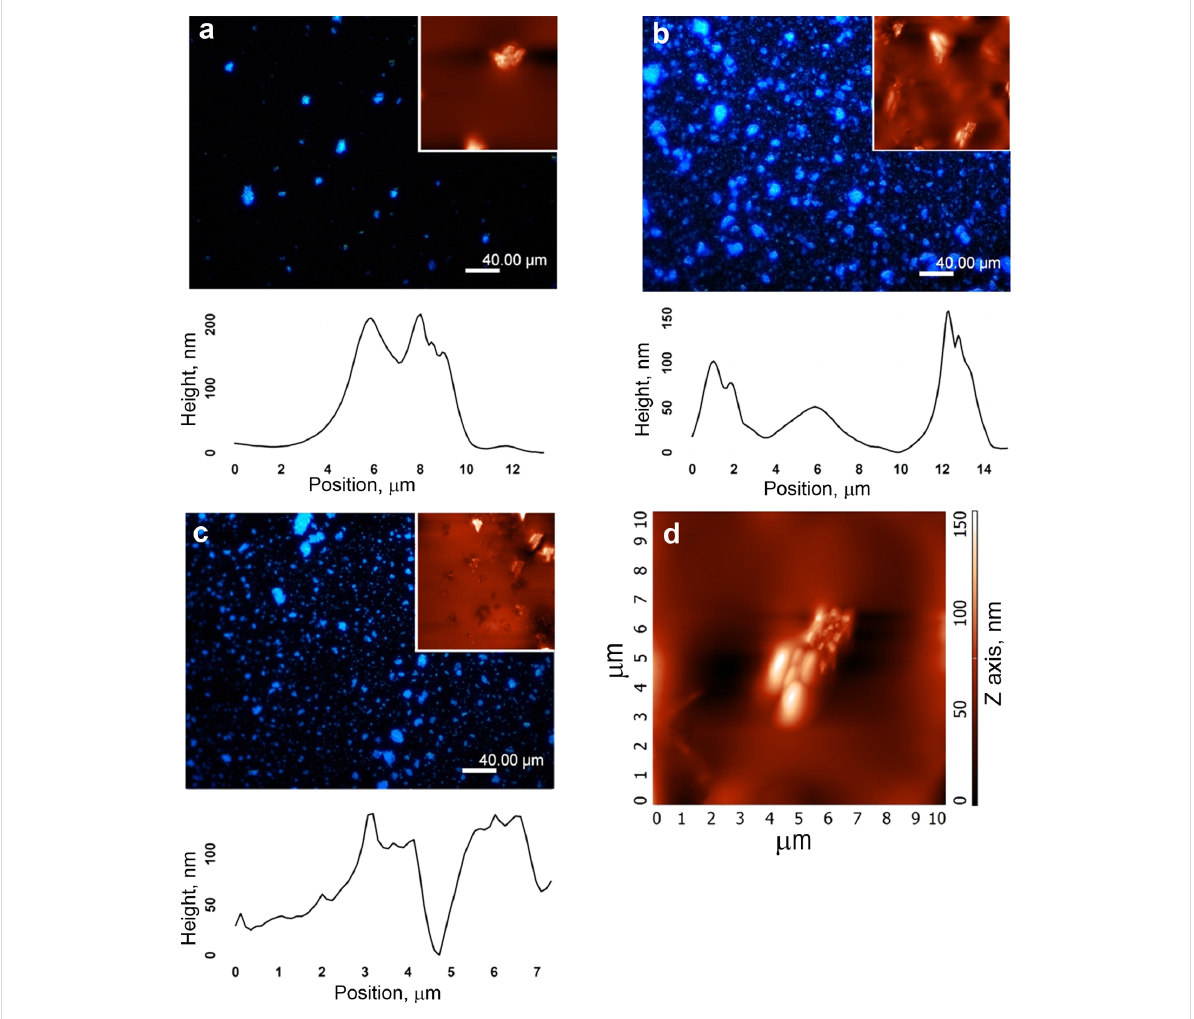
Figure 4: Fluorescence microscopy image, corresponding AFM magnification X,Y = 20 µm (inset) and cluster profile of PT5 (a) PT15 (b) and PT30 (c) films. d) AFM detail of a typical cluster.